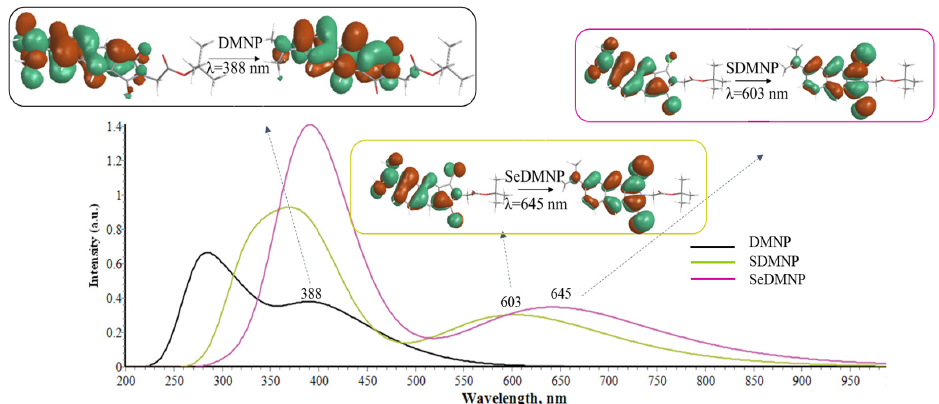
Figure 5. Computed Absorption Spectra of DMNP, SDMNP, and SeDMNP in DMSO environment at the B3LYP/6-31+G(d,p) level of theory and Natural Transition orbitals (NTOs) characterizing the bright lowest energy transition for each compound. See SI for more details.